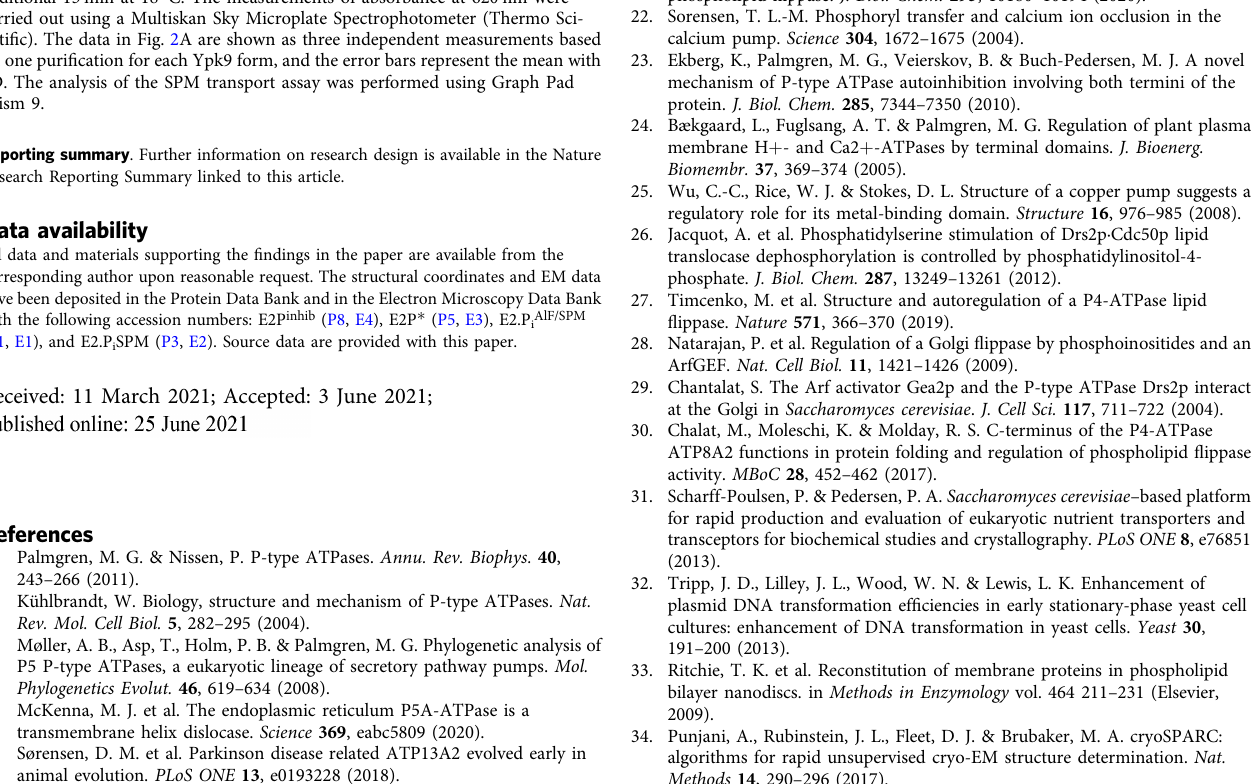
Figure preparation . All fi gures were generated using UCSF Chimera 41 and ChimeraX 42 . Alignments were performed using Clustal Omega 43 and visualized using ESPript 3.0 44